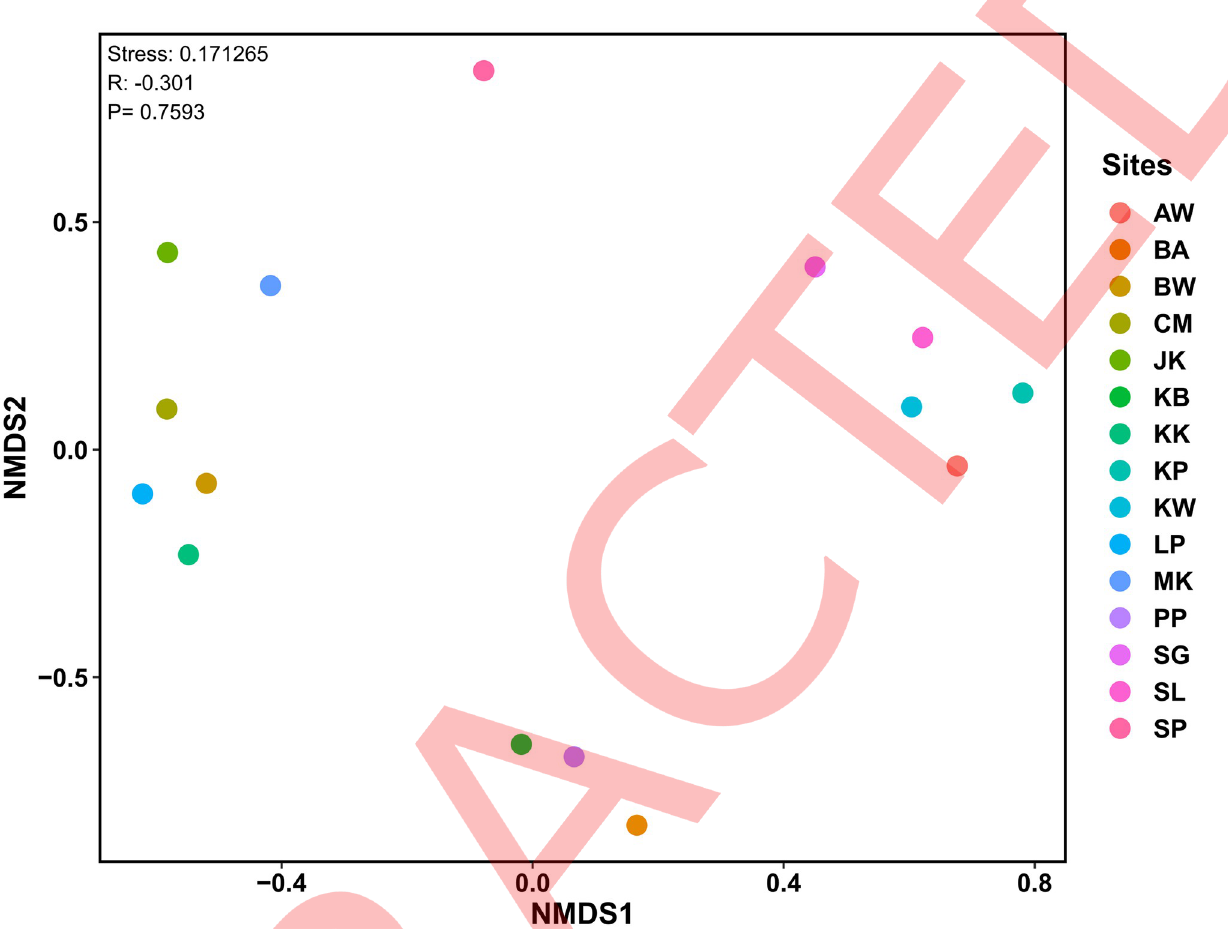
Fig 10. Non-metric multidimensional scaling (NMDS) based on Bray-Curtis dissimilarity matrices showing beta-diversity among different studied sites. AW: Ajuwali; BA: Bhagwal Awanan; BW: Ballanwala; CM: Chak Mandhaar; JK: Jorian Kalan; KB: Kotli Bhutta; KK: Kala Khambra; KP: Kapurowaali; KW: Khambranwala; LP: Lalpur; MK: Machi Khokhar; PP: Pindi Panjoran; SG: Sagarpur; SL: Salehpur; SP: Saidpur.